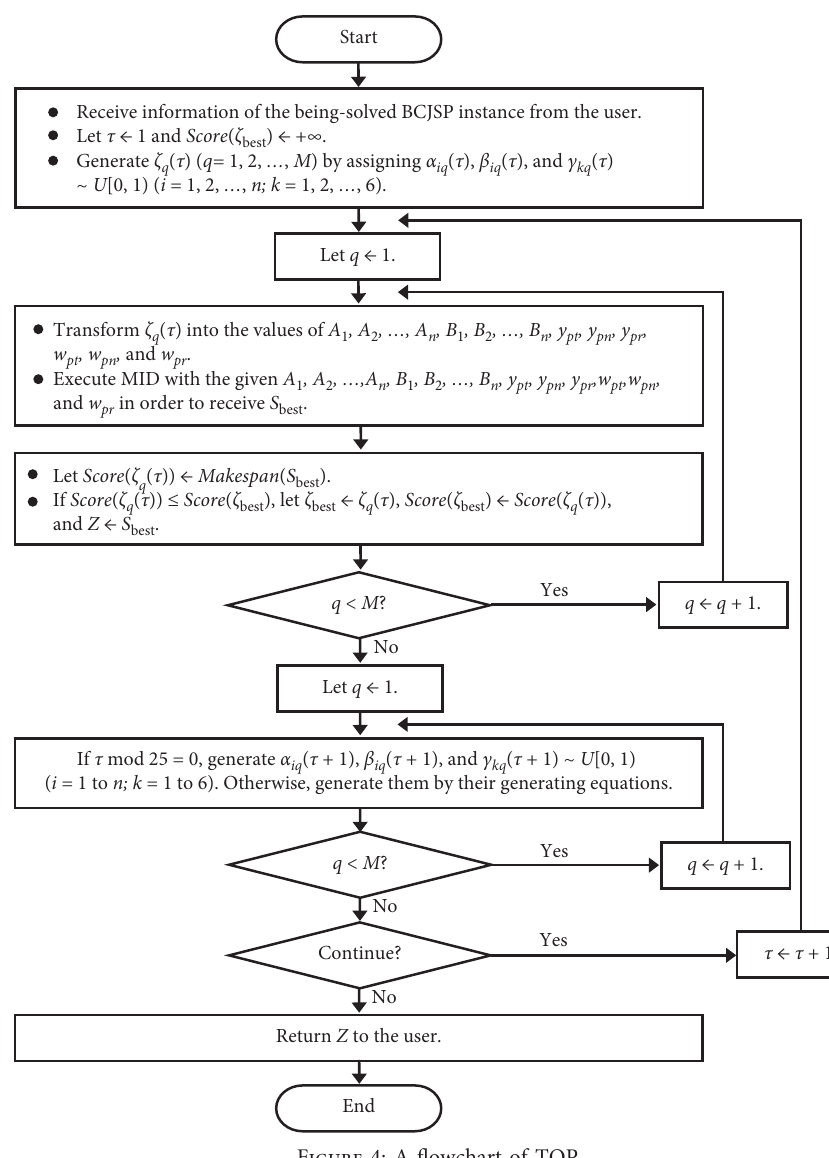
Figure 4: A flowchart of